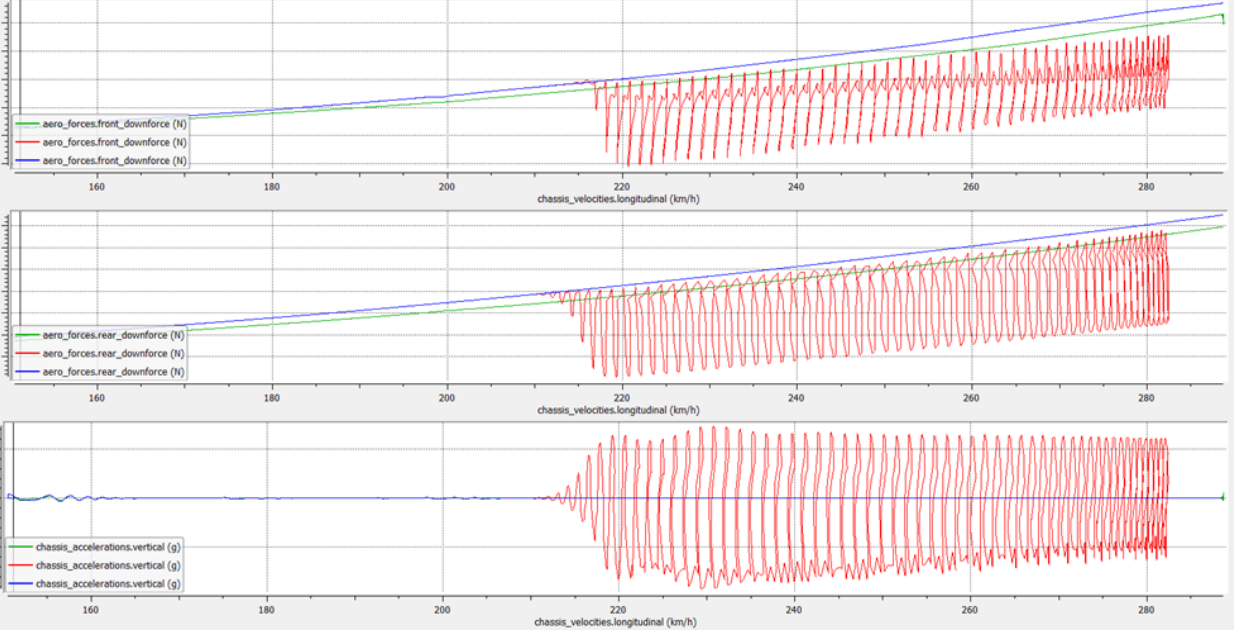
Figure 29. With the final static ride height variations FRHS +10 mm, RRHS +20 mm (#4, green) the downforce is reduced compared to the original configuration (#1, blue) but porpoising is no longer there. In this plot front downforce ( top ), rear downforce ( center ), and vertical acceleration ( bottom ) are shown.